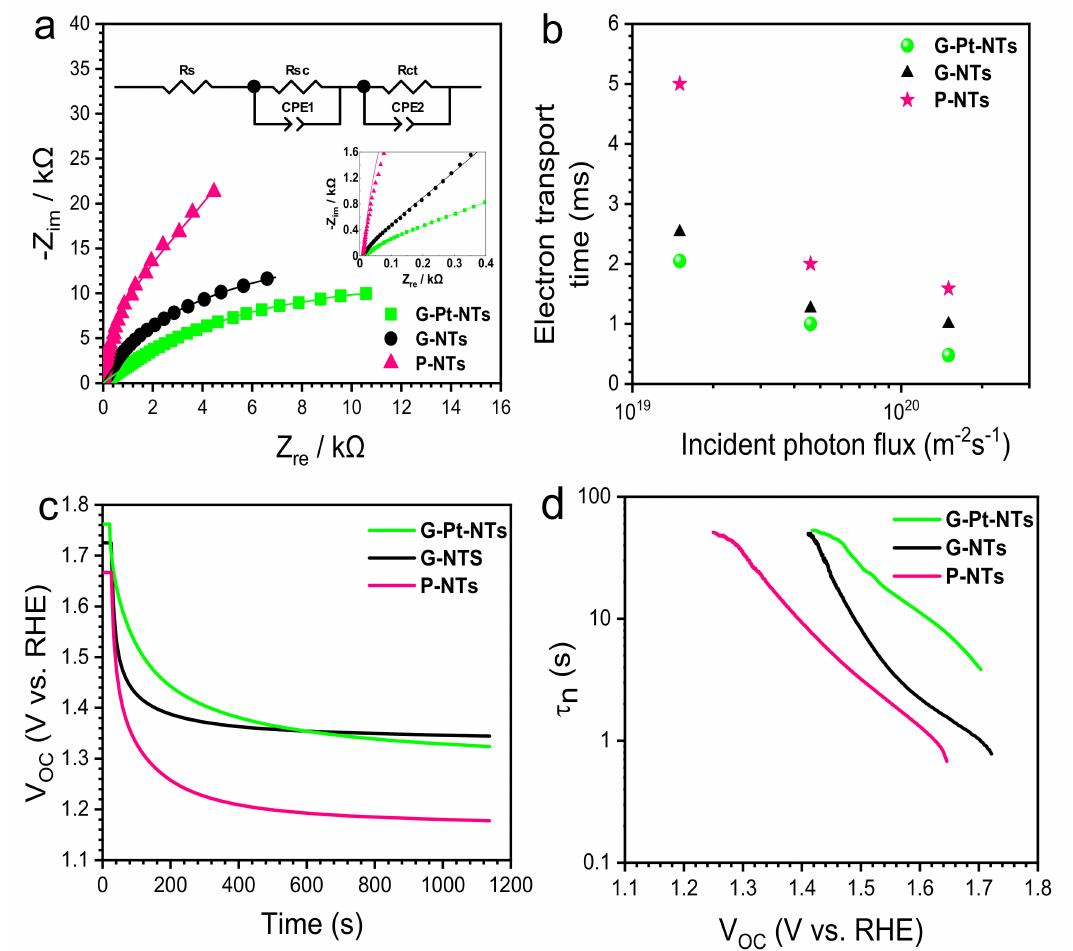
Figure 5. ( a ) Nyquist plots representing electrochemical impedance spectra of P-NTs, G-NTs, and G-Pt-NTs samples obtained in 1 M NaOH solution at 1.5 V vs. RHE. The inset shows EIS at high frequency and the equivalent circuits used to fit the impedance spectra. ( b ) Comparison of transport time of photogenerated electron for the P-NTs, G-NTs, and G-Pt-NTs samples as a function of incident photon flux for monochromatic light at 369 nm. ( c ) Open-circuit photovoltage decay measurement of P-NTs, G-NTs, and G-Pt-NTs under one sun (100 W / m 2 –AM 1.5 G) illumination, and ( d ) corresponding electron